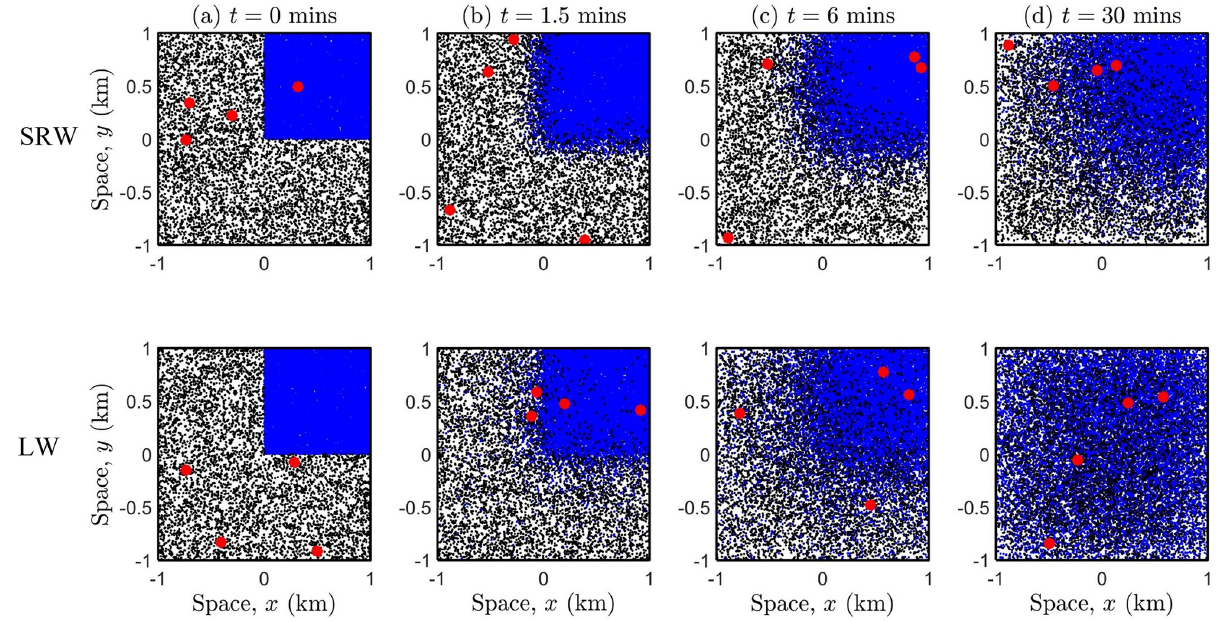
Fig 5. Population mixing due to different movement types in a heterogeneous spatially distributed population, in the absence of a lockdown. The mobility parameter for the SRW is σ = 0.1 and for the LW γ = 0.1536, see also Eq (18). All other parameter values are the same as that in the caption of Fig 3.